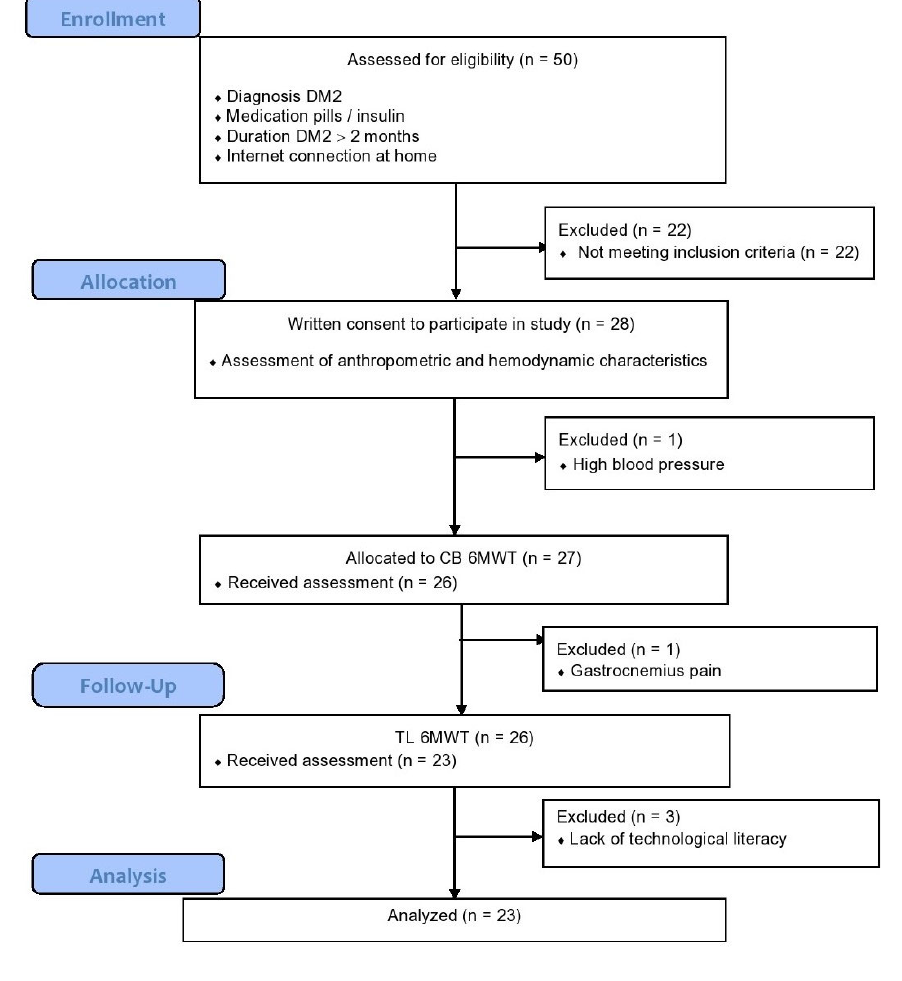
Figure 1. Flowchart of the study.